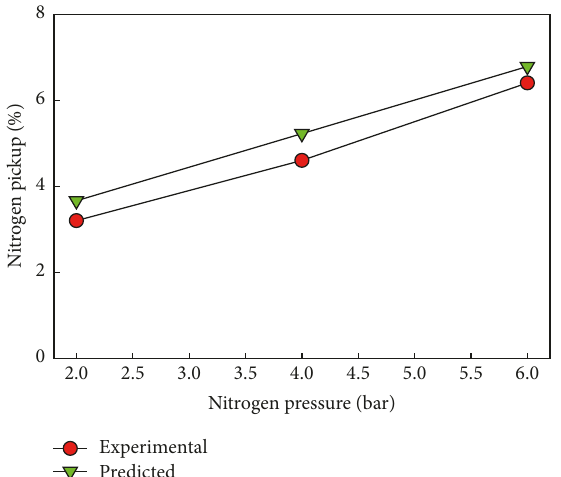
Figure 3: Variation between the predicted and published nitrogen pickup of medium carbon (1.2% C) ferromanganese at different nitrogen pressure at 950 ∘ C and after 6 hours [10,